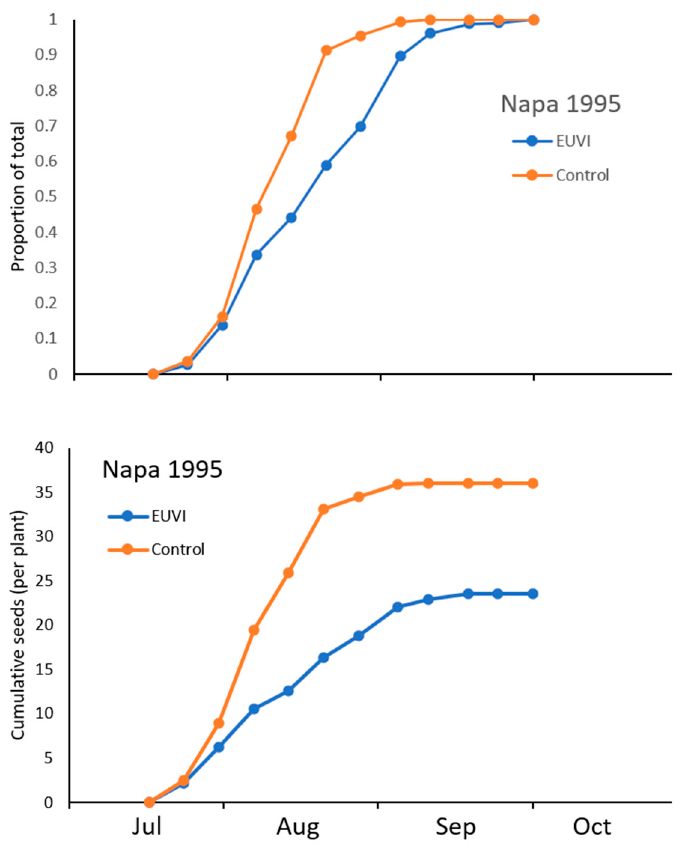
Figure 5. ( A ). The cumulative proportion of capitula produced by Centaurea solstitialis plants growing Fig 5 with (diamond) and without (circle) Eustenopus villosus . ( B ). The cumulative total of seeds per plant for the same plants in ( A